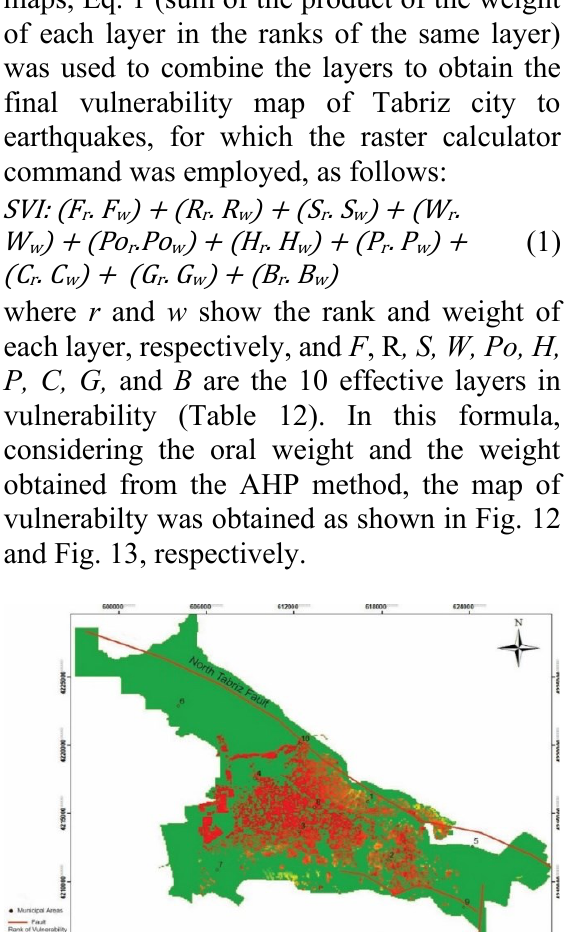
Fig. 14. Final map based on Fuzzy